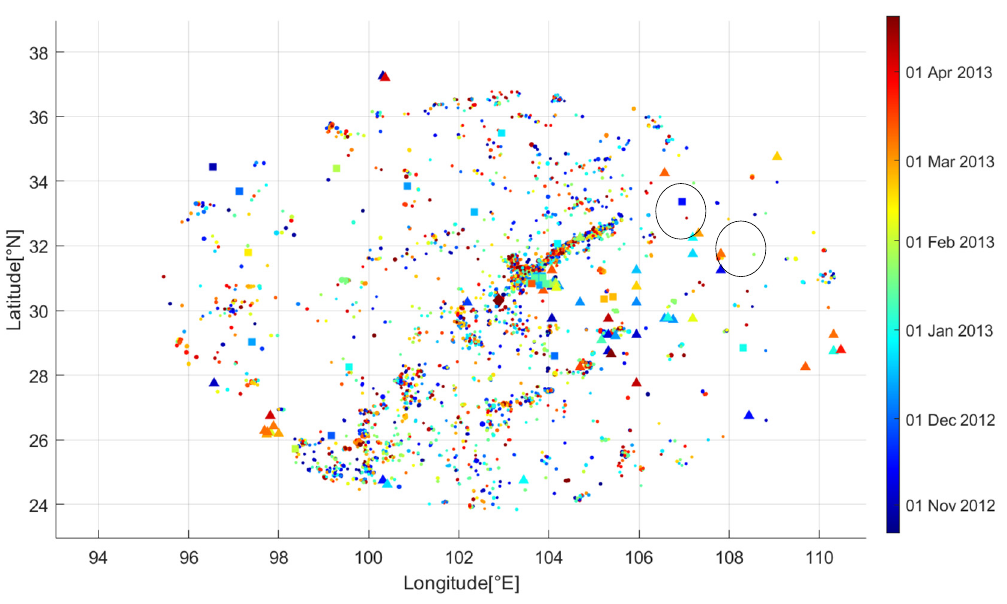
Figure 25. Three ‐ dimensional map of anomalies or events in the lithosphere, atmosphere, and ion ‐ Figure 25. Three-dimensional map of anomalies or events in the lithosphere, atmosphere, and osphere. The diamond represents the Lushan earthquake. ionosphere. The diamond represents the Lushan